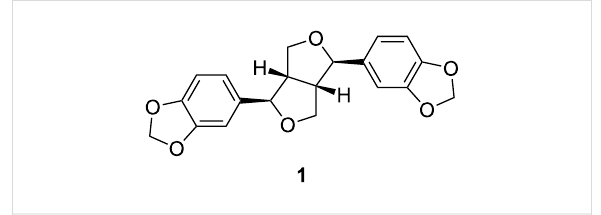
Figure 1: Known compound sesamin ( 1 ) isolated from methylene extract of stem bark of Z. paracanthum .